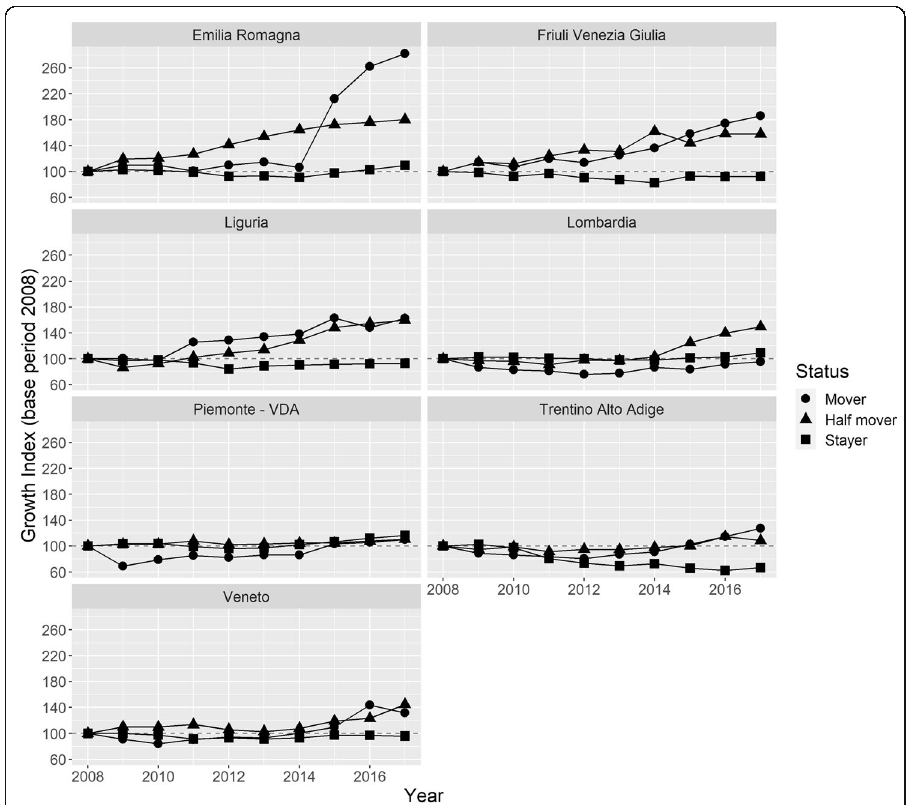
Fig. 4 Growth rates for stayers , half movers , and movers by region of origin, benchmark 2008 (2008 –